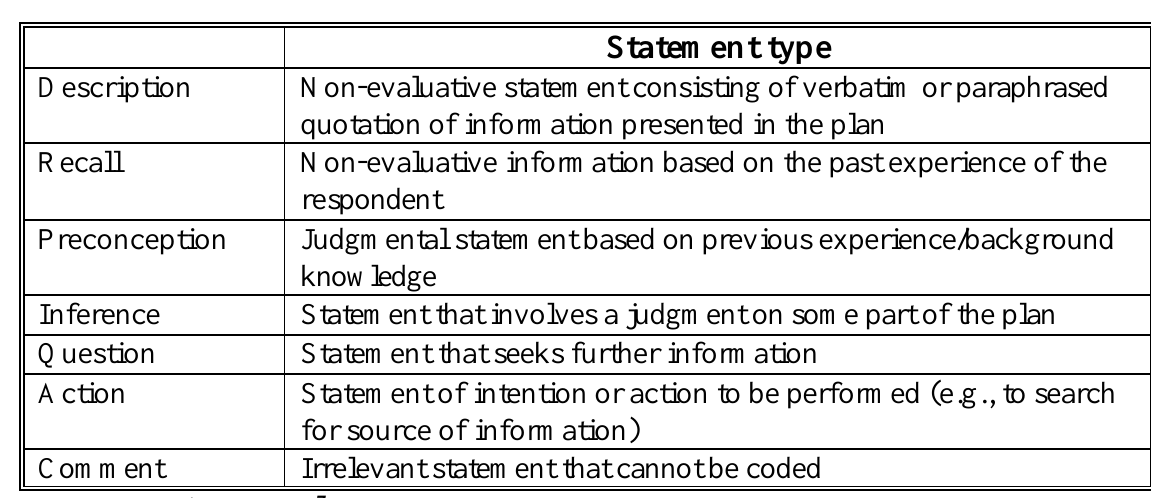
Thought segment protocol